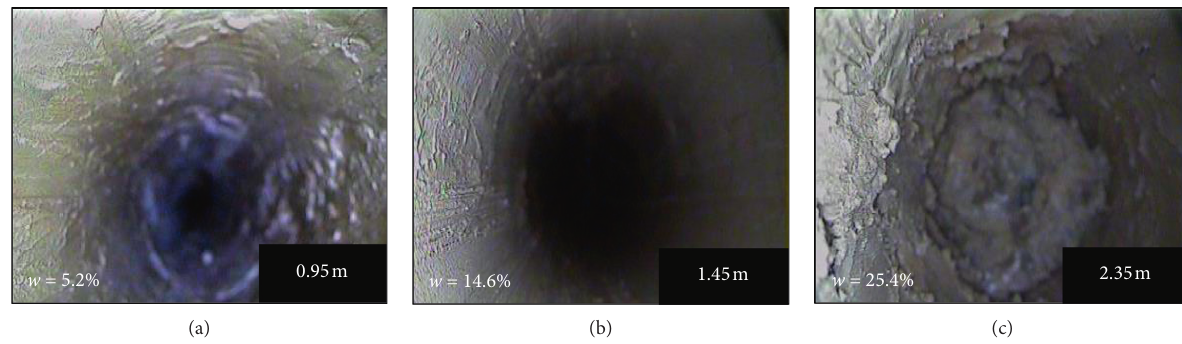
Figure 13: Cross sections of inner-wall surface of the drilled hole.